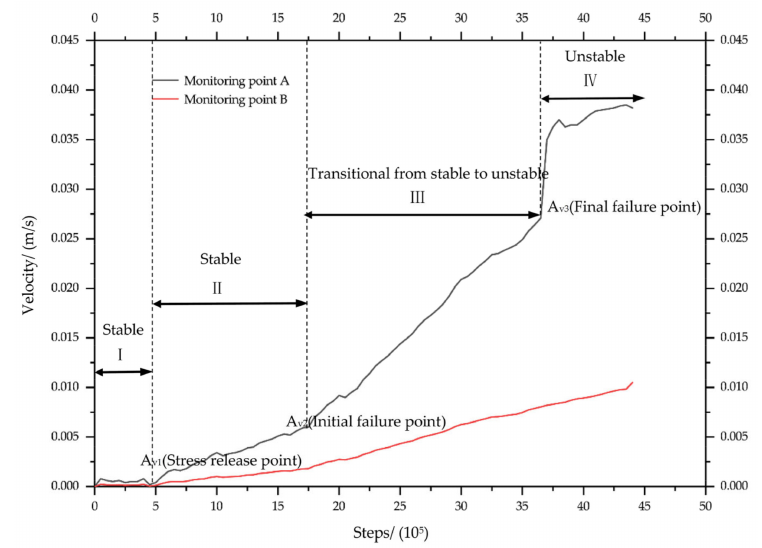
Figure 17. Graphs showing the velocity of monitoring points A and B as a function of simulation steps.